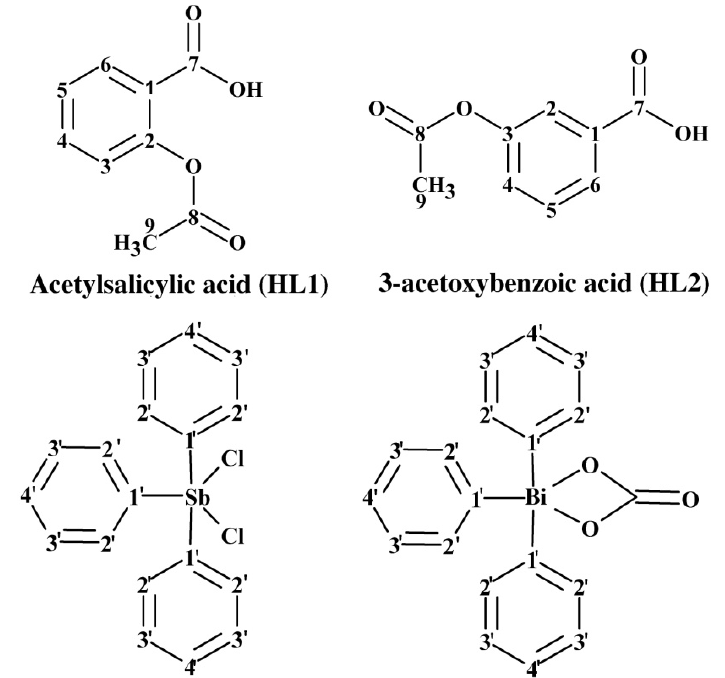
Figure 1. The chemical structures of the ligands; acetylsalicylic acid (HL1) and 3-acetoxybenzoic acid (HL2), and metal precursors; triphenylantimony(V) dichloride and triphenylbismuth(V) carbonate with the carbons numbering scheme used in this